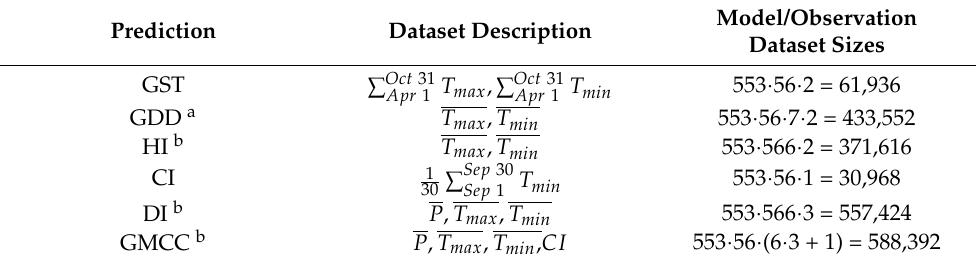
Table 2. Summary description of model-observation datasets that were developed for the Willamette Valley American Viticultural Area to evaluate the performance of Localized Constructed Analogs (LOCA) Coupled Model Intercomparison Project phase 5 (CMIP5) [40,41] ensembles to calculate